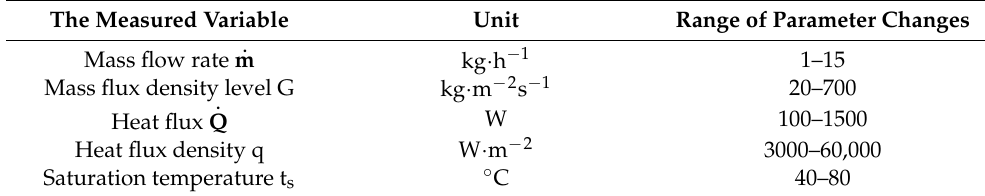
Table 2. The scope of experiment carried out during HFE 7000 and HFE 7100 refrigerants’ external condensation in shell-and-tube heat exchangers.